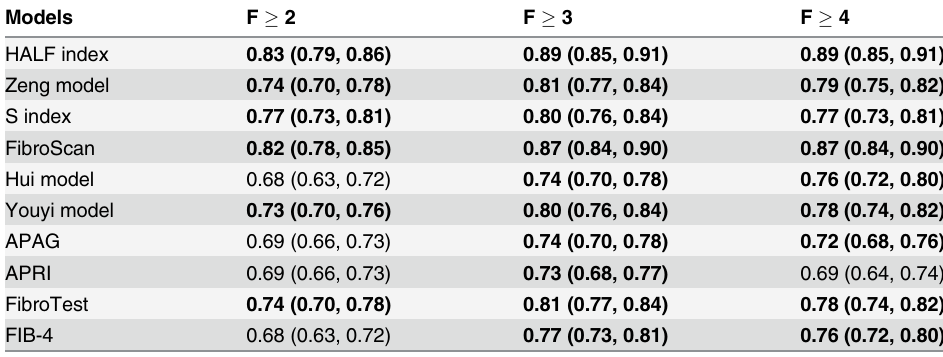
Table 4. AUROC and 95%CI for each model, according to METAVIR Fibrosis Stages.